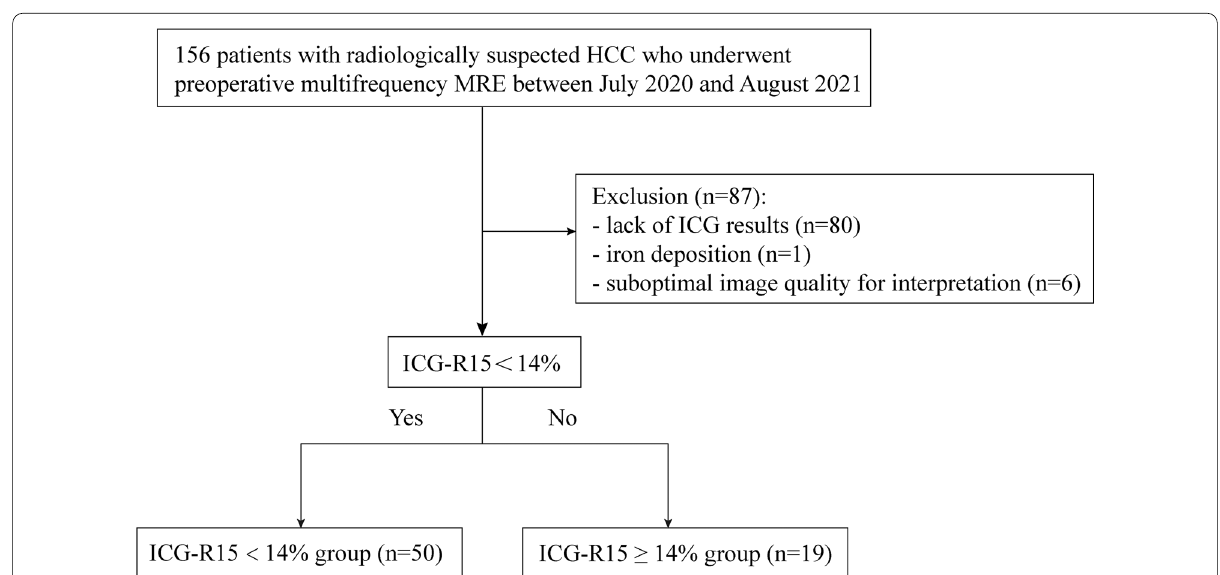
Fig. 1 Flow diagram of the study participants. HCC: hepatocellular carcinoma, ICG: indocyanine green, ICG-R15: 15-min ICG retention